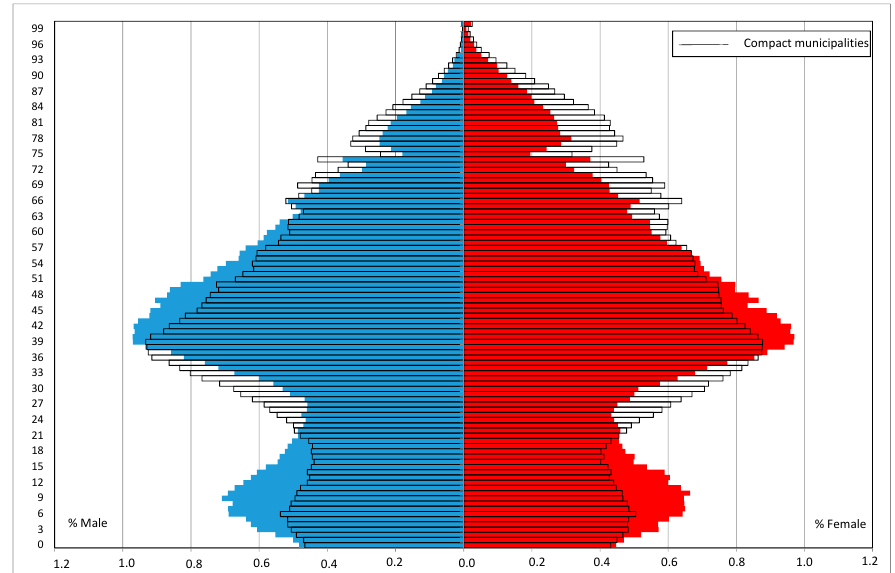
Figure 5. Sex and age structure in BMR dispersed municipalities, 2015. Source: Compiled by the authors based on Padrón Continuo (Continuous Register), 1 January 2015, INE.